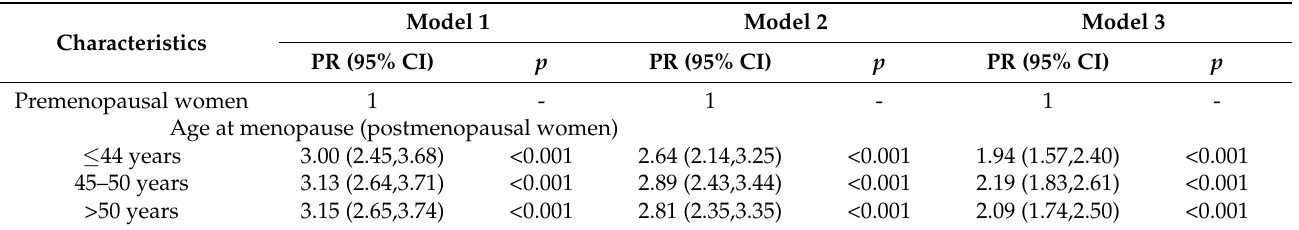
Table 3. Prevalence ratios (PR) (95%CI) for T2DM in premenopausal and postmenopausal women with different age at menopause.